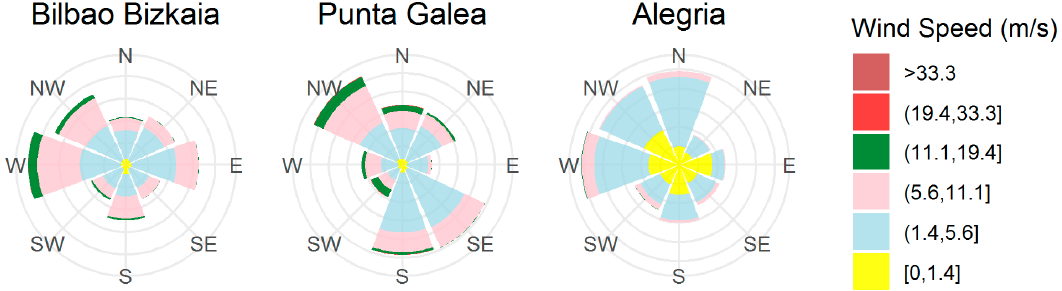
Figure 2. Wind roses corresponding to the period (2007–2014).